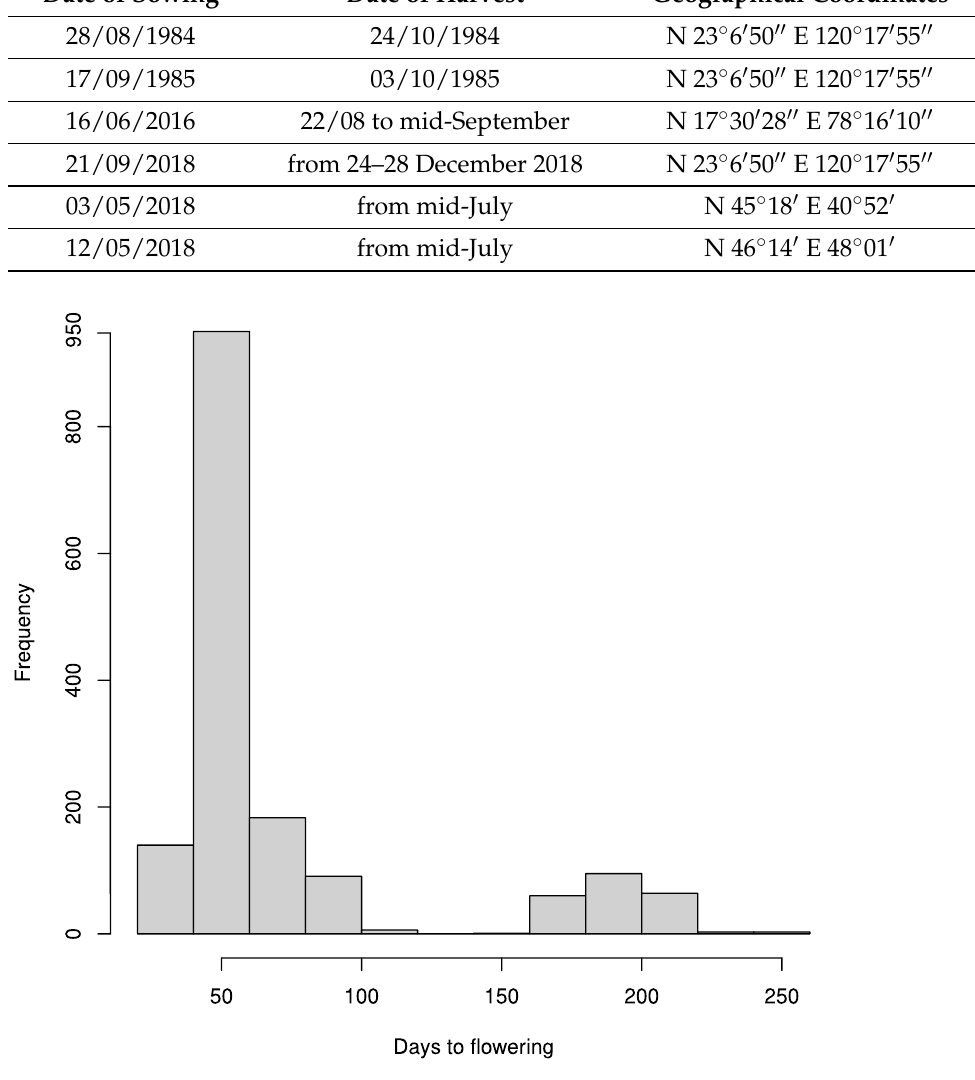
Figure 2. Histogram of time to flowering for